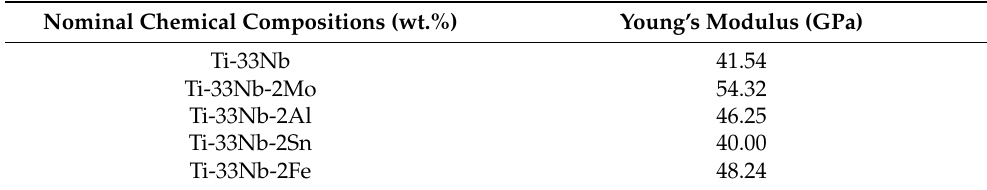
Table 2. The Young’s modulus of water-quenched Ti-33Nb-2X (X=Al, Sn, Fe and Mo) alloys obtained from the compression